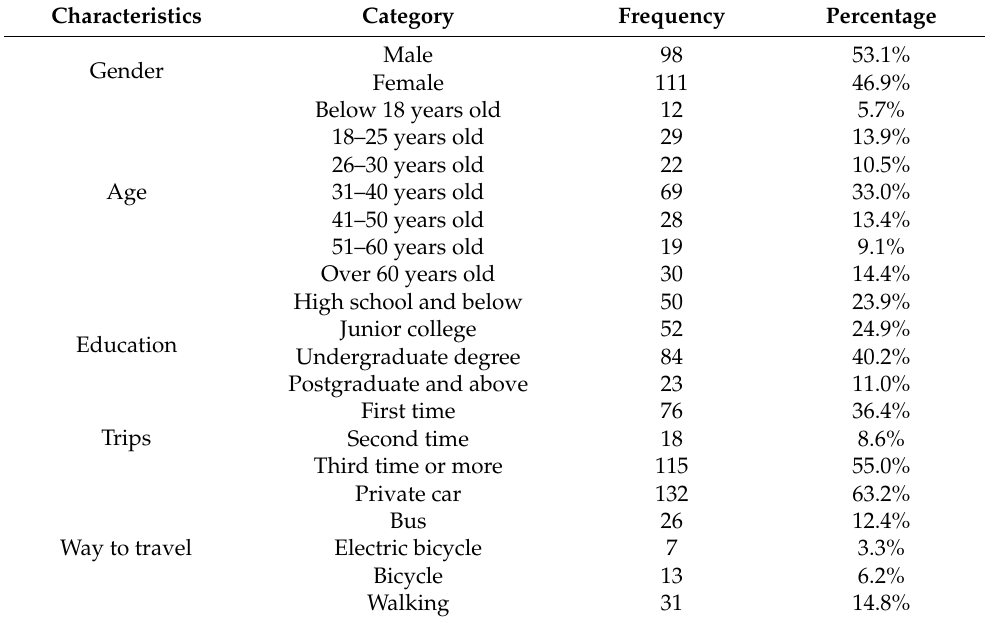
Table 3. Statistics of personal information and travel characteristics.